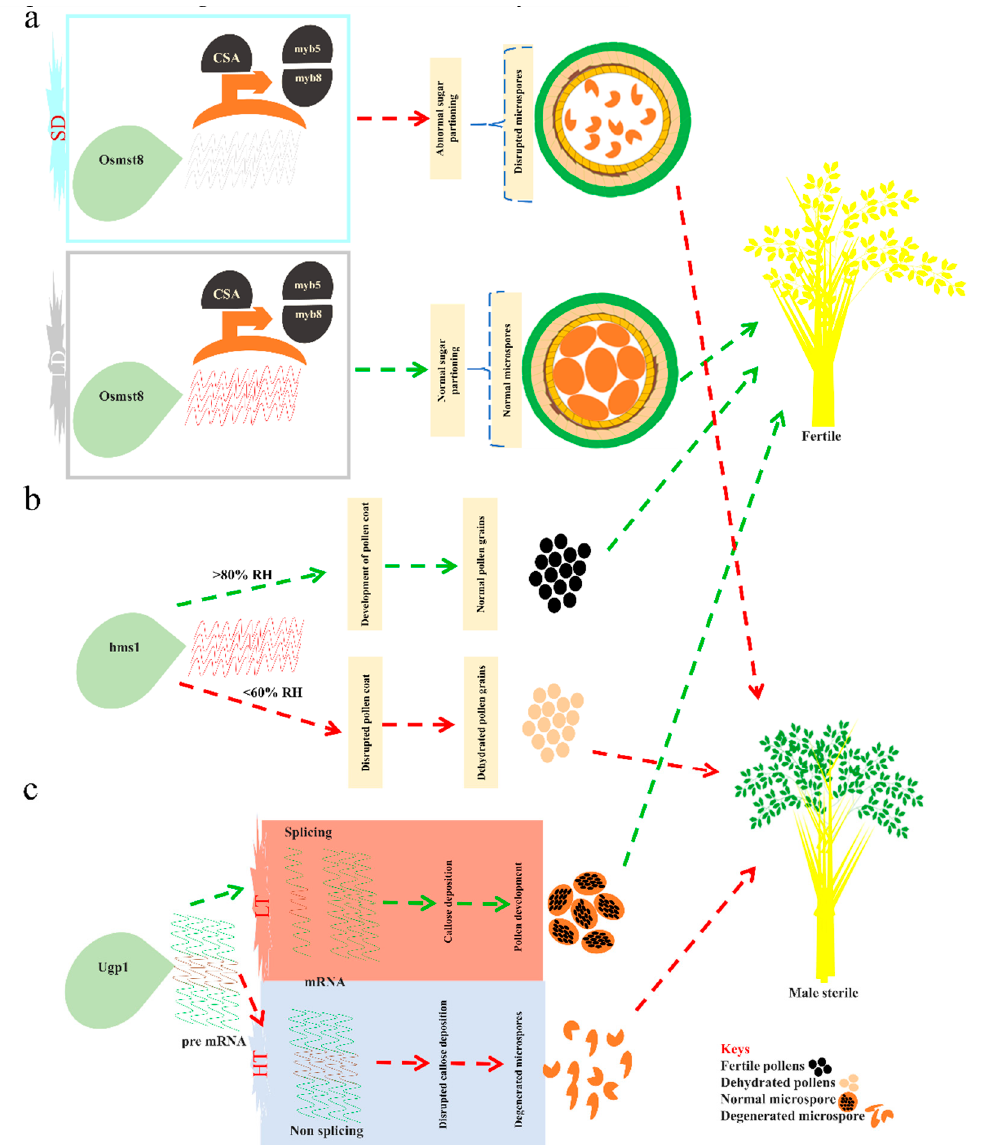
Figure 5. Transitional regulation of male fertility and sterility in EGMS-Lines. ( a ) Regulation of sugar partitioning in anther via the carbon-starved. The transcription factor CSA is a key player for sugar regulation from leaf to anther through direct regulation of transporter OsMST8 for normal anther reproduction. Under a short day, CSA mutation can lead to downregulation of OsMST8 transcription and be unable to transport sugar from flag leaves to anthers, resulting in male sterility. While, long-day (LD) conditions along with other regulators might switch regulation of this process and lead to normal anther development and male fertility. ( b ) The hms1 mutants regulate male reproduction under varying relative humidity (RH) percentage. It showed male sterility at low RH ( < 60%) and restored male fertility at high RH ( > 80%) via normal development of the anther. ( c ) Functional regulation of UPD-glucose pyrophosphorylase 1 (Ugp-1) under fluctuating temperature. Under high-temperature (HT) Ugp-1-overexpression rice plants revealed a high accumulation of nonspliced transcript of Ugp1 leading to male sterile plants, whereas under low-temperature (LT) successful splicing of Ugp1 transcript restored male fertility and normal seed